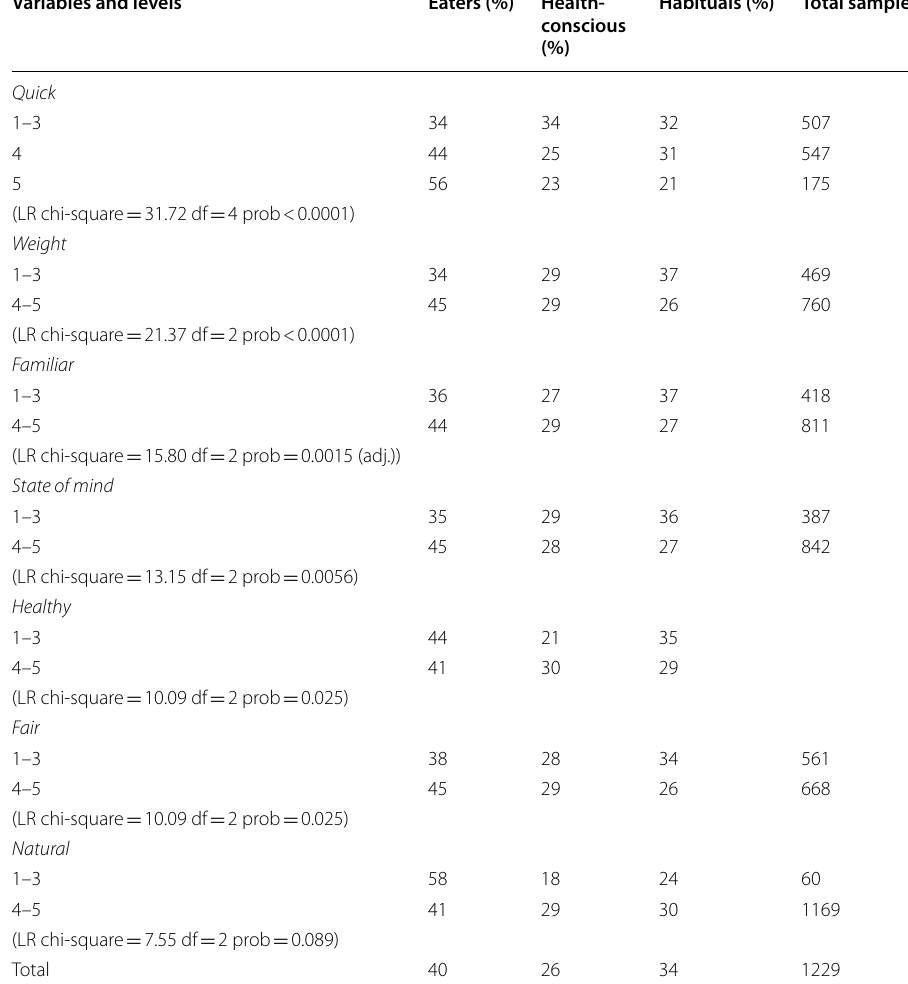
Table 10 Percentage differences with respect to the FCMs in the three clusters Variables and levels Eaters